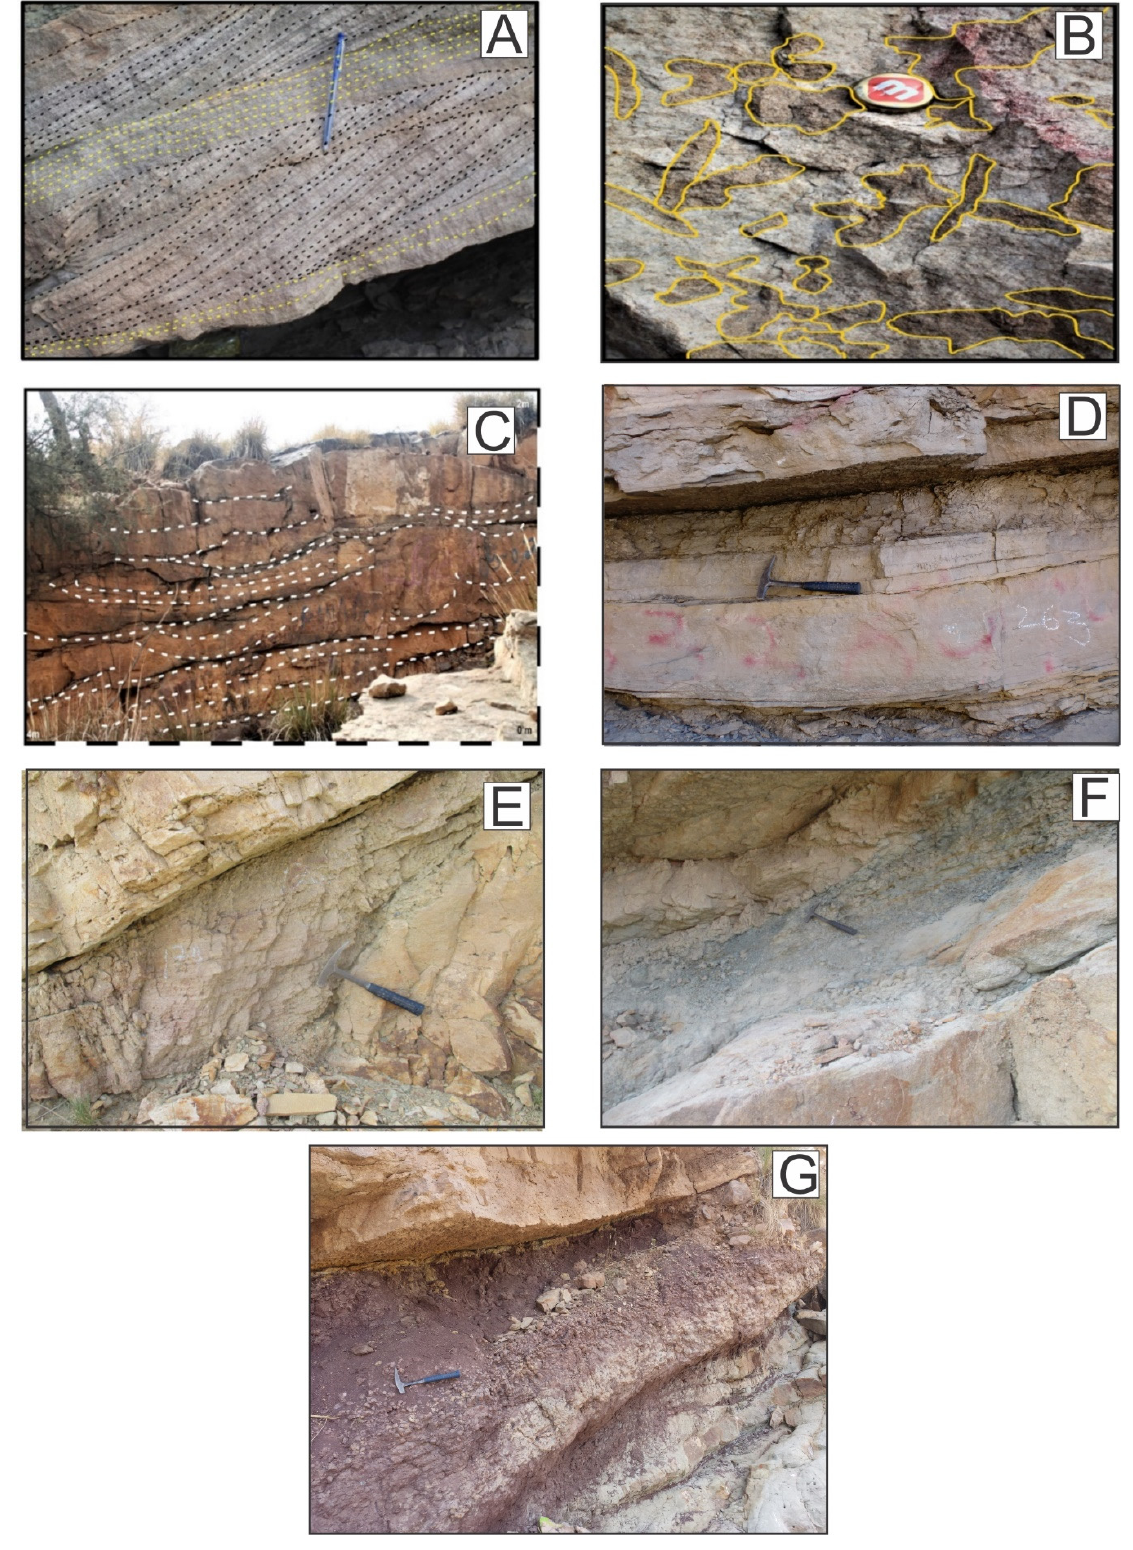
Figure 5. ( A ) Planar cross-bedded sandstone element; ( B ) trace fossil sandstone element; ( C ) trough cross-bedded sandstone element; ( D ) fine sandstone element; ( E ) channel fill deposit element; ( F ) laminated shale sheet element; ( G ) Paleosol element.